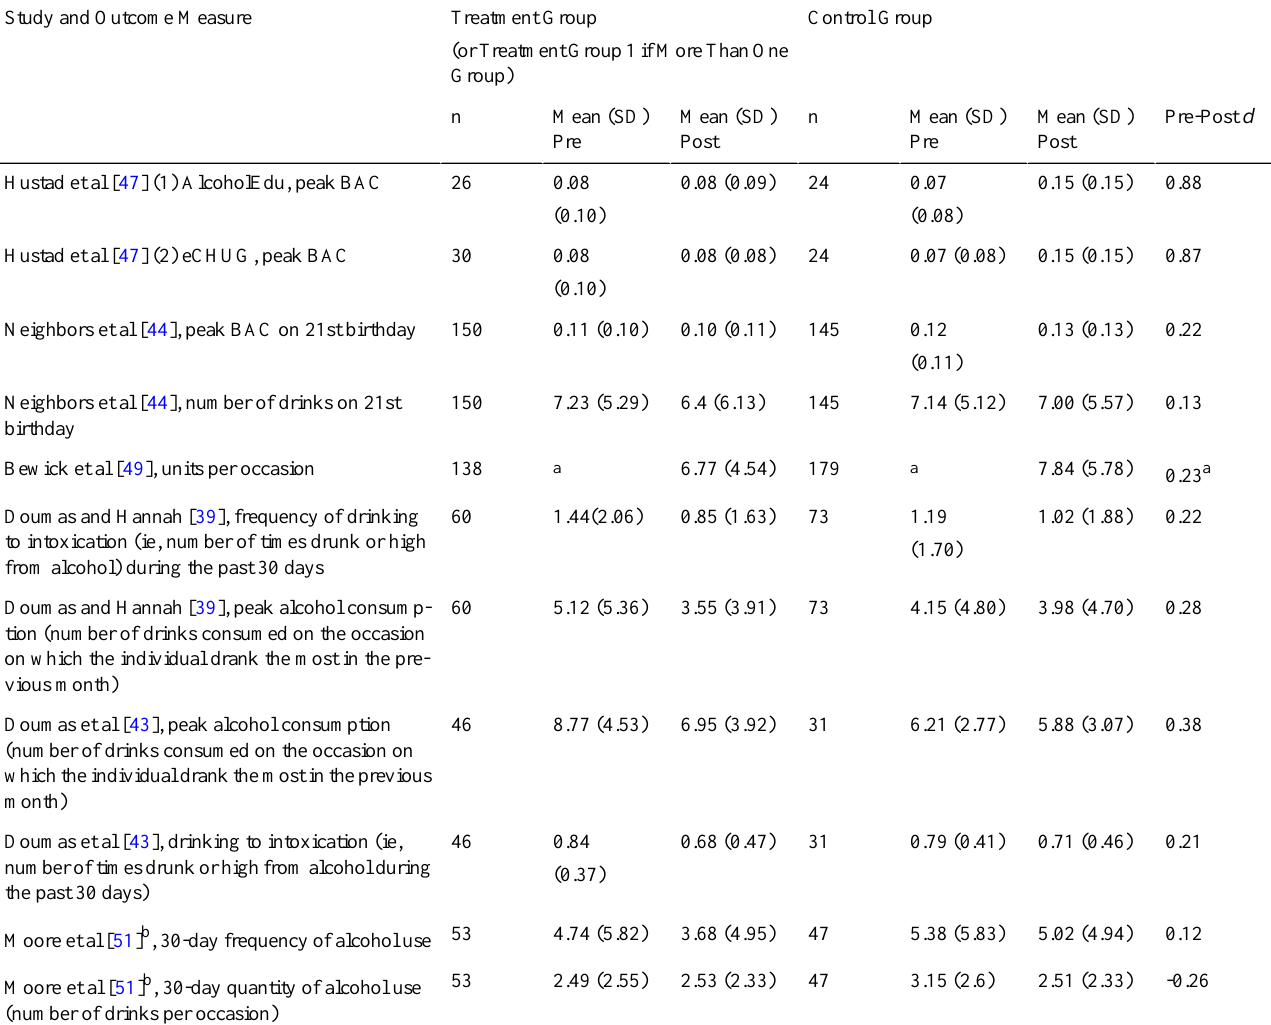
Table 3. Randomized controlled trials of online alcohol interventions: Effect sizes (d) obtained across blood alcohol concentrations and